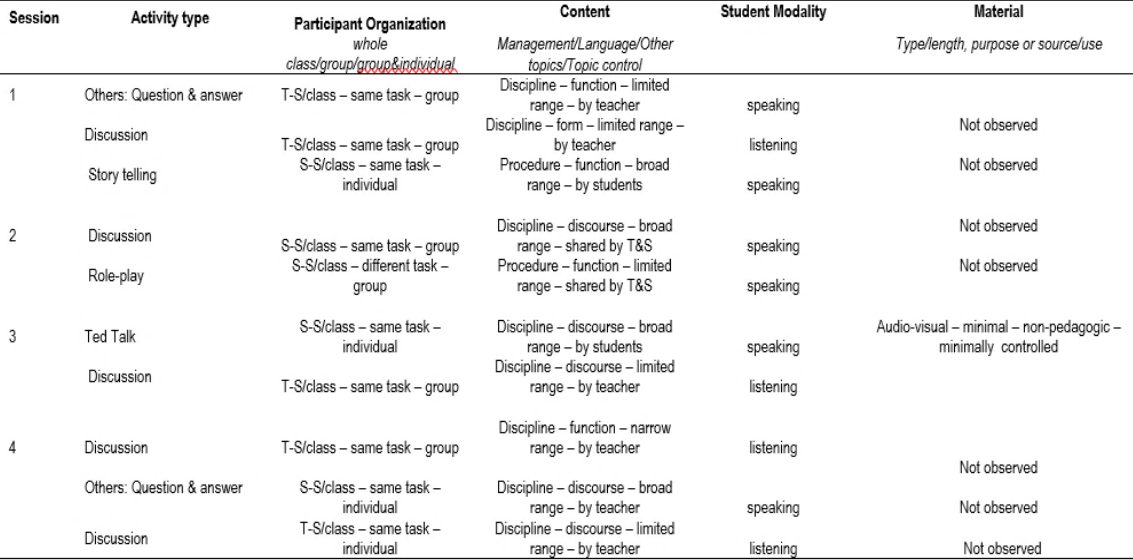
Table 1. Summary Table of Communicative Events in the English Language